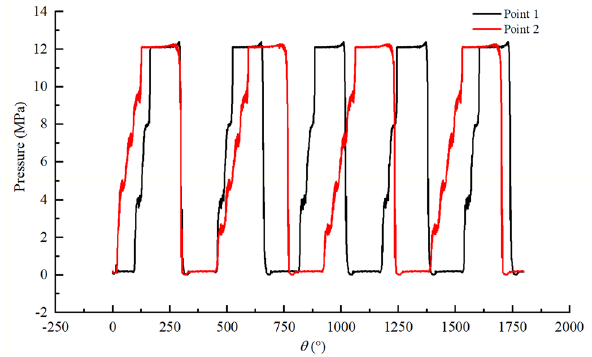
Figure 13. The pressure changes in tooth cavity with rotation angle of external gear.